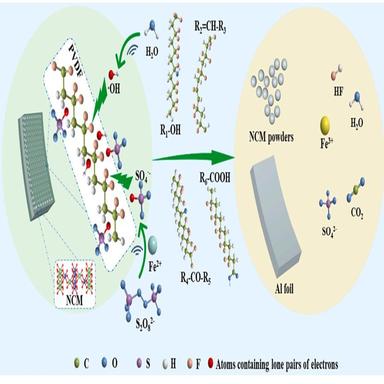
The detailed exfoliation process and corresponding mechanism in USFH.